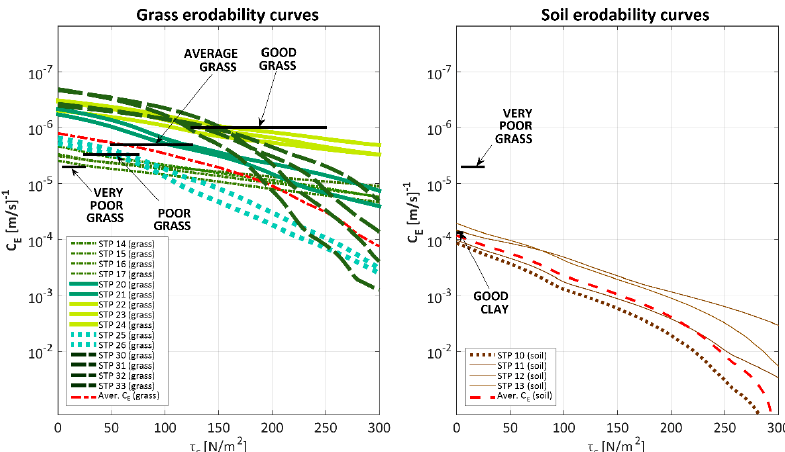
Figure 11. C E curves for each STP for grass (left) and bare soil (right). Horizontal lines represent the grass quality reference intervals for very poor, poor, average, and good grass cover quality reported in [19].